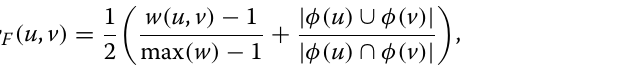
Fig. 2 The clustering-based feature extraction approach consists of three stages. Namely, creation of affinity graph, clustering computation, and Gene Ontology term enrichment. Its inputs are a GCN, denoted by G = ( V , E , w ) , a set of functions A , an annotation function φ : V → 2 A , and a set K = { k 0 , ... , k m are two feature matrices (for both G and its enriched version F ) of dimension V × A · K → [ 0,1 ] that specify how likely it is for the genes to be associated to the functions in A when the graph is decomposed m clusters, each of size k i , for 0 ≤ i ≤